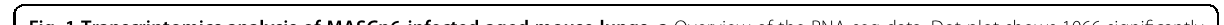
Fig. 1 Transcriptomics analysis of MASCp6-infected aged mouse lungs. a Overview of the RNA-seq data. Dot plot shows 1066 signi fi cantly differentially expressed ( P < 0.05 and |log 2 FC| > 1) genes with 298 downregulated and 768 upregulated in the infected group. FC, fold change. b GO analysis of signi fi cantly upregulated genes. Rich factor represents the ratio of signi fi cantly differentially expressed genes to the total genes belonging to the GO term. c Heatmap and bar plot show relative expression levels of signi fi cantly differentially expressed genes of chemokine, interleukin, and their receptors. d Network of the genes belonging to signi fi cantly-enriched immunity-related KEGG terms of signi fi cantly upregulated genes. e Heatmap and bar plot show relative expression levels of CD200 and its receptor genes. f Immunostaining results with SARS-CoV-2 nucleocapsid (green) and macrophage marker (CD68, red) antibodies of lung sections from MASCp6-infected and control aged mice. Scale bars, 200 μ